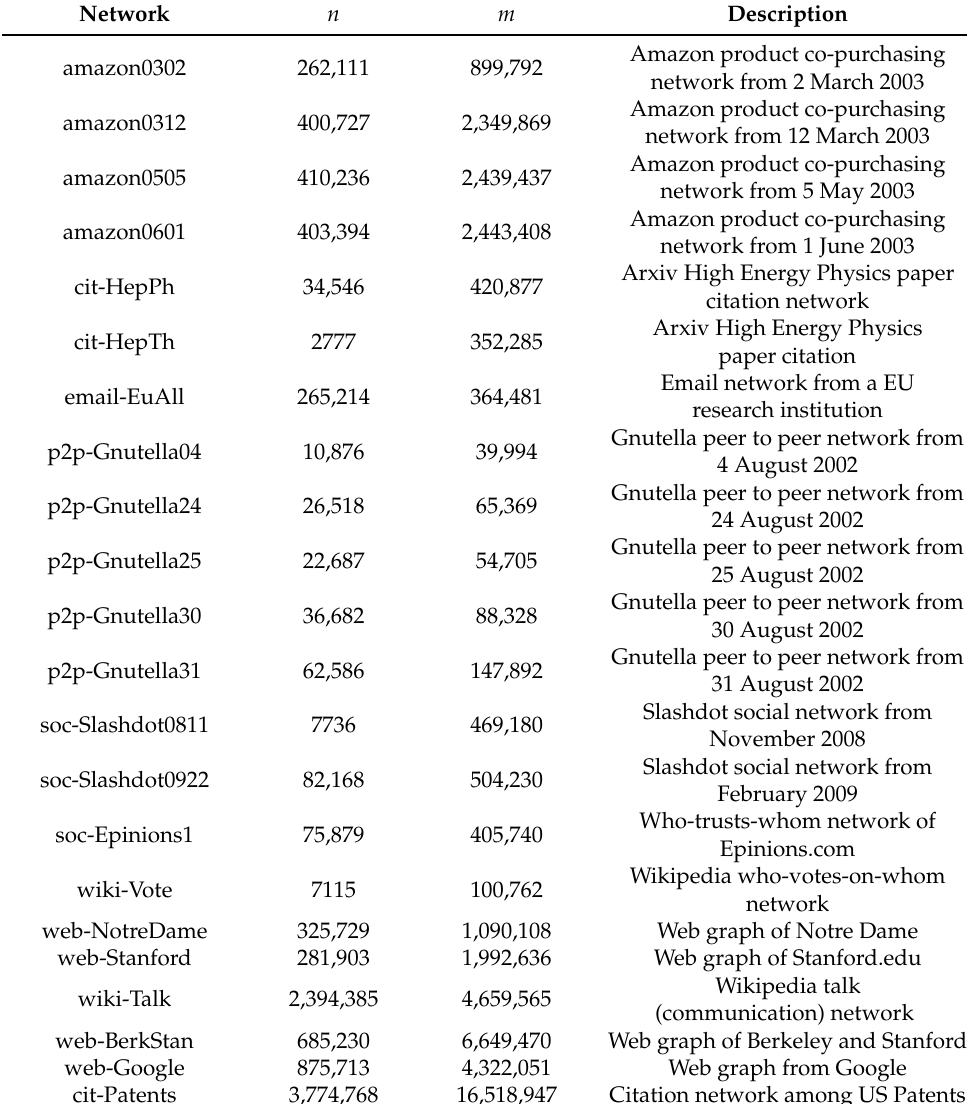
Table 4. SNAP networks used in